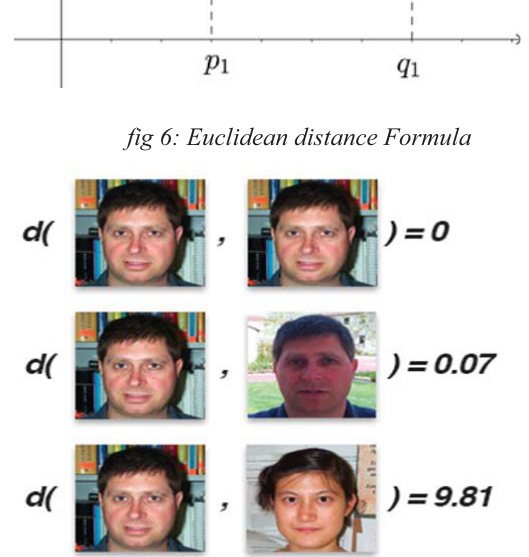
fig 7: Comparing the Euclidean distance determine same